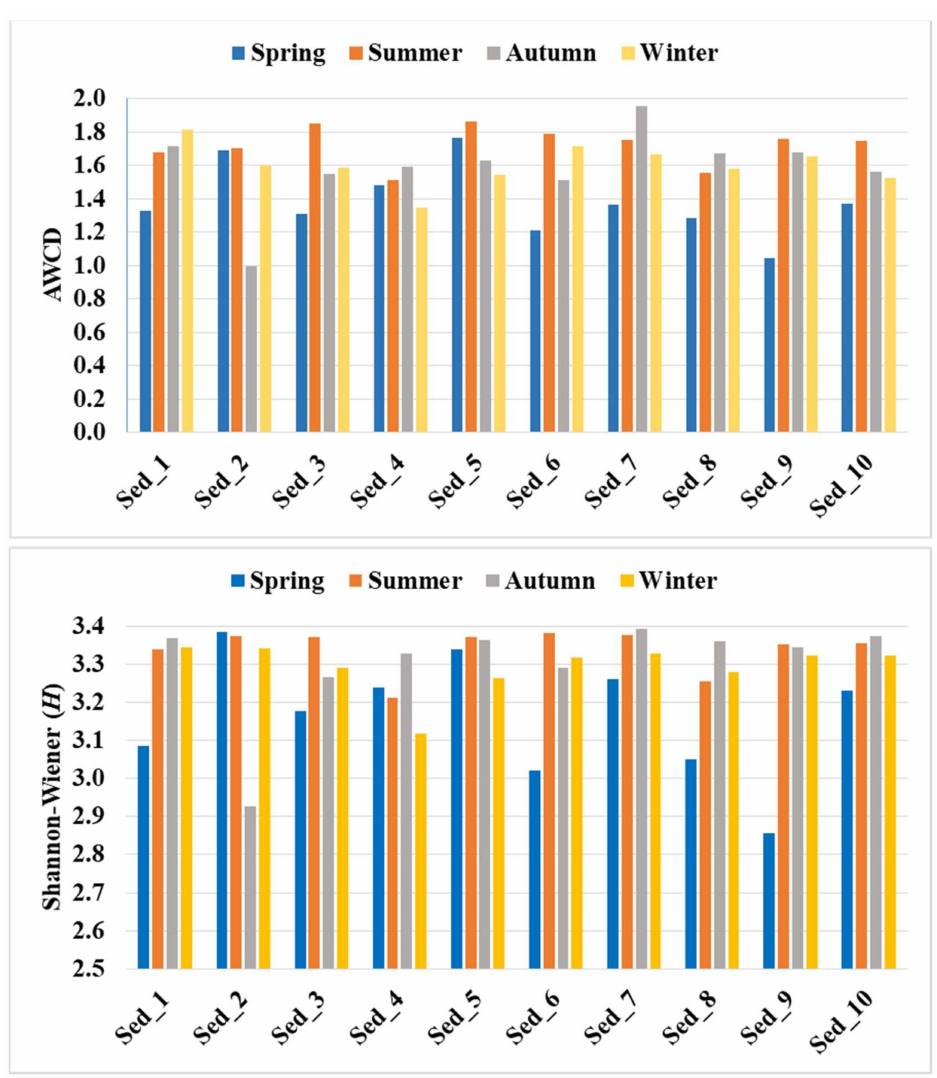
Figure 6. Average Well Color Development (AWCD) and Shannon–Wiener (H) levels in 10 bottom sediment sampling points in the four